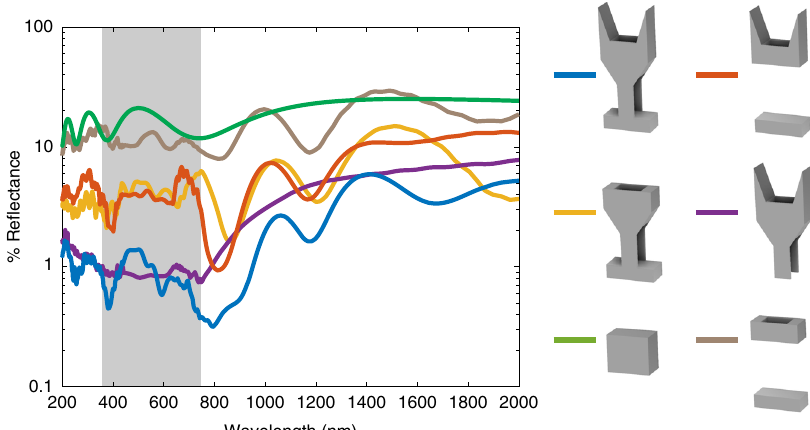
Fig. 3 Removing conserved structural elements increases re fl ectance 3- to 16-fold. Re fl ectance of two overlapping scales backed by a 100% re fl ecting white surface simulated with the fi nite-difference time-domain method (unit cell for each simulation is shown). Included is the full-scale model (blue), scales with the trabeculae removed (red), with the ridges removed (yellow), with the basal lamina removed (purple), both ridges and trabeculae removed (brown), and a rectangular block made of the same volume of absorbing material as the full-scale (green). Full scales re fl ect 2.5 – 10% of the light re fl ected from a rectangular block of absorbing material. Removing the robust trabeculae or ridges increases re fl ectance by 3- to 16-fold, while the lamina has little effect on the re fl ectance. Curves are made by averaging fi ve simulation runs with unit cell sizes spanning + / − 5% of the standard cell.